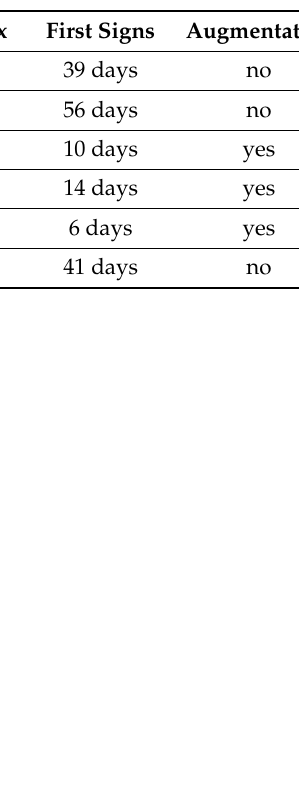
Figure 3. Blade positions of patients with mechanical failure.